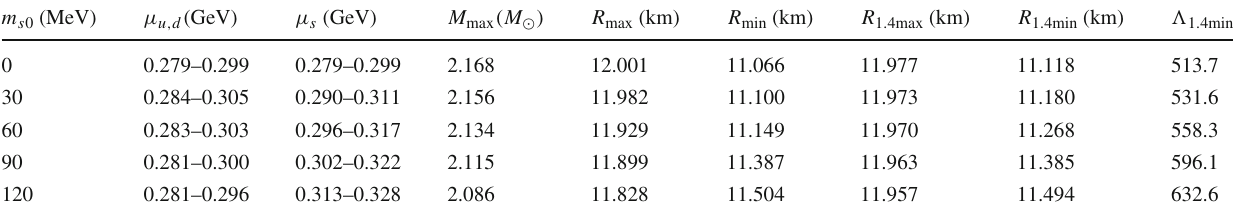
the minimum radius R min , and the maximum radius R 1 . 4max , the min- imum radius R 1 . 4min and the minimum tidal deformability (cid:2) 1 . 4min for 1 . 4 M (cid:2) strange quark stars, with different strange quark masses m s 0